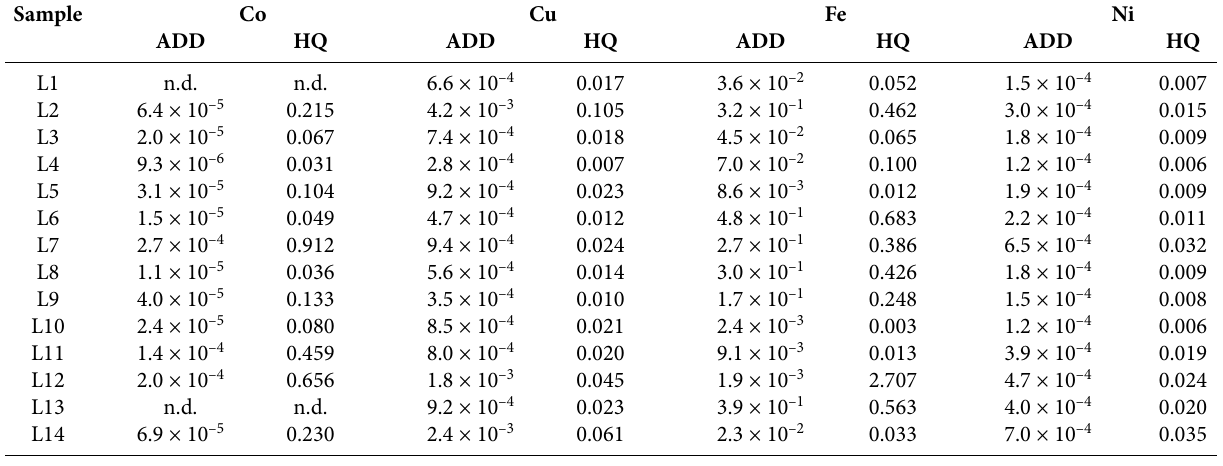
Table 5. Health risk assessment for the exposure to Co, Cu, Fe, Ni, Zn, Mn, Cr, and Cd in the lipstick samples Sample Co Cu